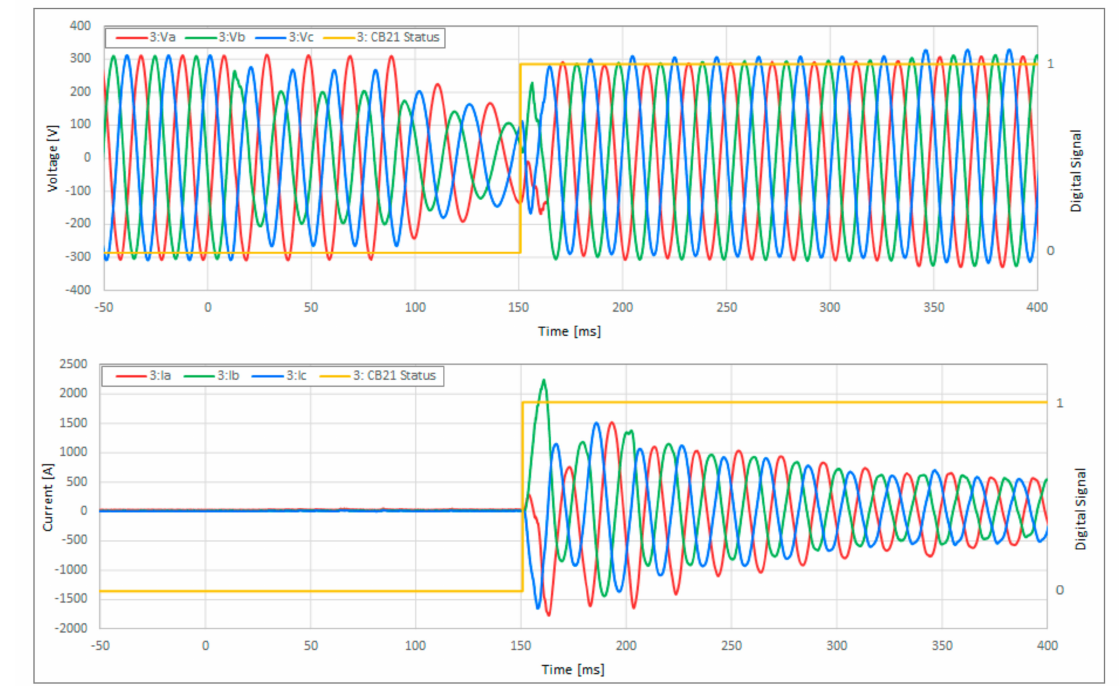
Figure 7. F2 line-to-line fault event traces: one of two Battery Energy Storage System (BESS) inverter terminal voltages ( top chart) and terminal currents of the same BESS inverter ( bottom